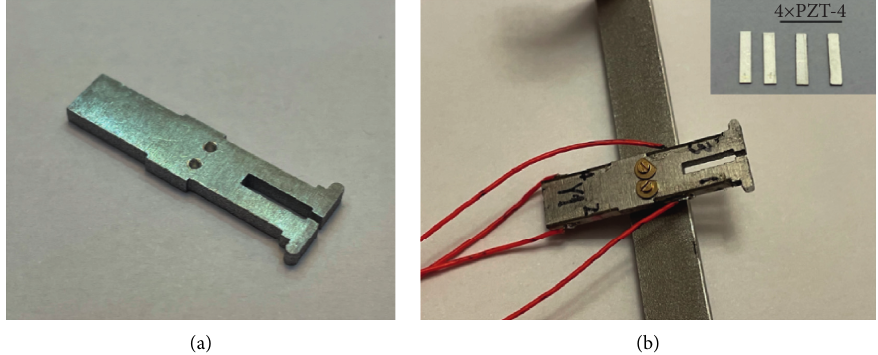
Figure 12: Prototype of the stator. (a) Stator elastomer. (b) Stator with PZT and